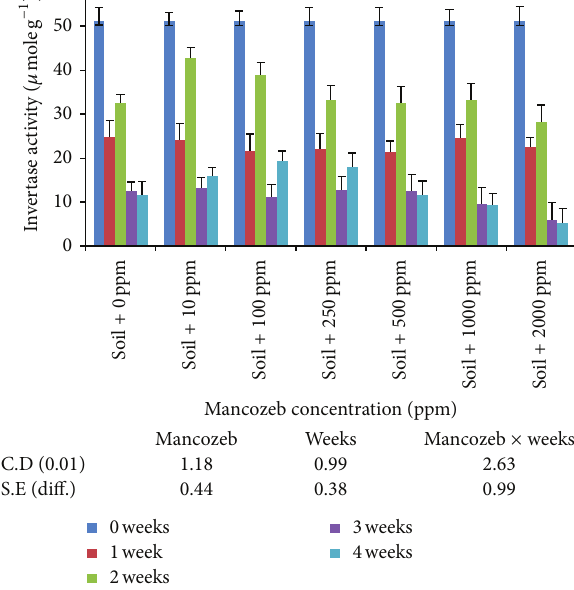
Figure 9: Effect of mancozeb on invertase in